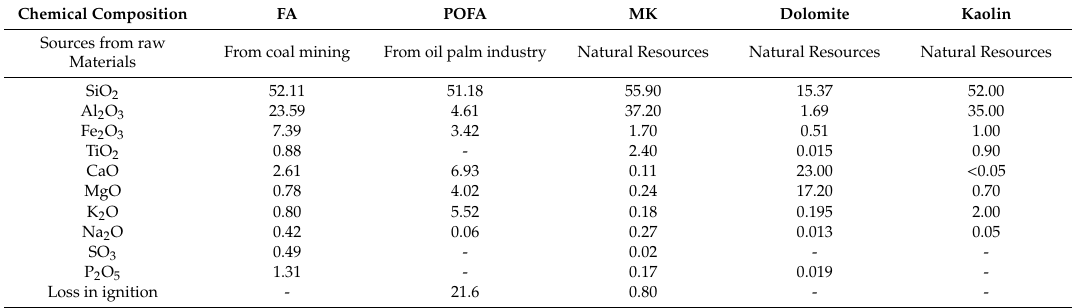
Table 1. X-ray fluorescence (XRF) analysis of di ff erent aluminosilicates modified from [30]. Chemical Composition FA POFA MK Dolomite Kaolin Sources from raw Materials From coal mining From oil palm industry Natural Resources Natural Resources Natural Resources SiO